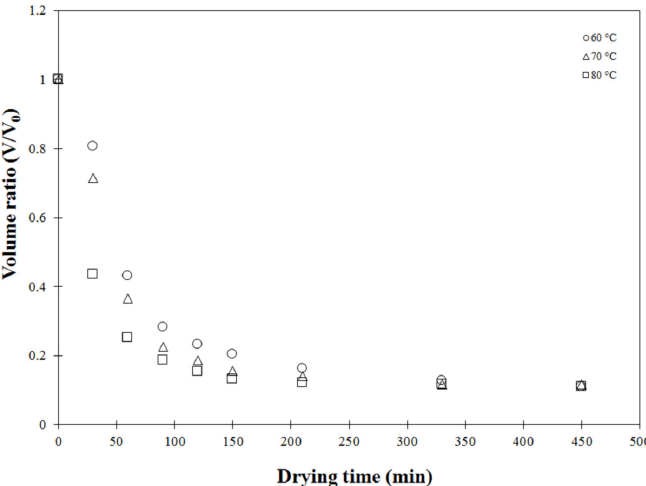
Figure 4. Experimental volume ratio ( V/V 0 ) as a function of drying time at different